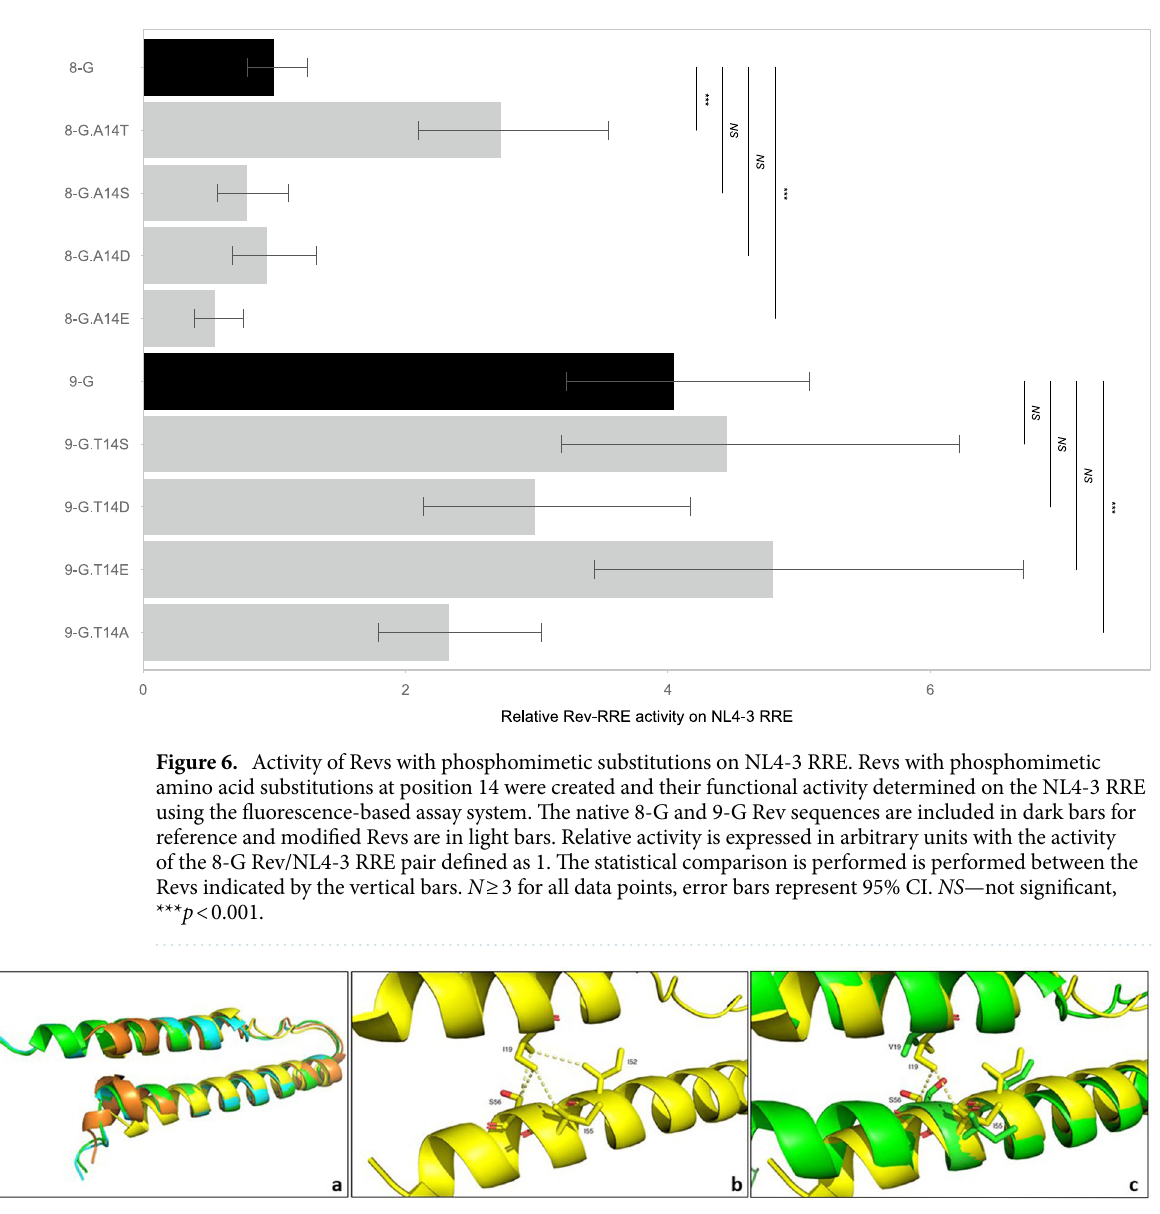
mutant relative to 8-G.A14T.